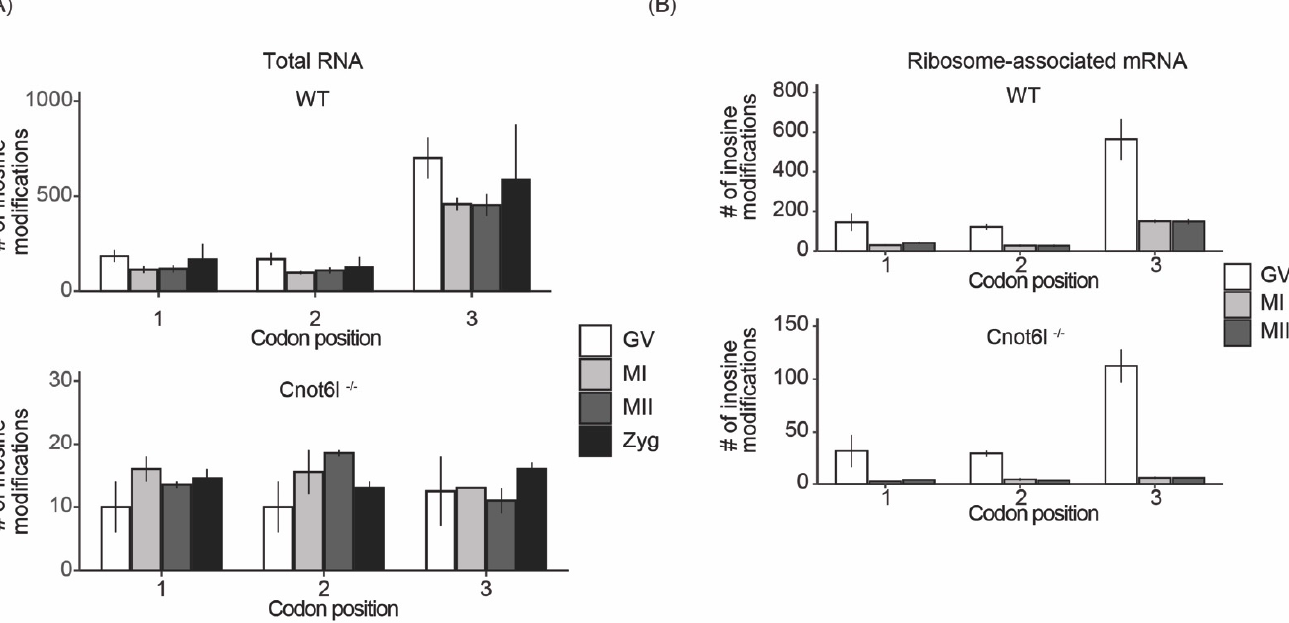
Figure 5. Inosines are enriched at the wobble position of codons in total RNA and ribosome-associated RNA. ( A , B ) Global frequency of inosine RNA modifications at the first, second, or third codon positions in WT, Cnot6l -/- , and Btg4 -/- samples in total RNA ( A ) and ribosome-associated RNA ( B ). Only codons from transcripts with TPM ≥ 1 were analyzed. 2.6. Efficiency of Inosine RNA Modifications is Highest in Ribosome-Associated mRNA Transcriptome-wide inosine RNA modification efficiency at various codons re- mained around 50% throughout oocyte maturation in WT samples (Figure 6A, Supple- mental Figure S2 shows raw counts). Conversely, Cnot6l -/- samples displayed defects in inosine RNA modification efficiency in total RNA at all stages of oocyte maturation (Fig- ure 6A, Supplemental Figure S3). An examination of inosine RNA modification efficiency in Btg4 -/- samples revealed a reduction of modification efficiency of select codons (Supple- mental Figure S4). The inosine RNA modification efficiency of zygotes decreased only in the Cnot6l -/- background (Supplemental Figure S6). The inosine RNA modification effi- ciency reached almost 100% within transcripts of ribosome-associated mRNA of WT sam- ples, and then decreased during oocyte maturation (Figure 6B and Supplemental Figure S5). Cnot6l -/- samples also displayed almost 100% efficiency of particular codons (AAA, AAC, AAT, AGA, CAA, CAG, CCA, CGA, GTA, TTA), however, other codons were not modified at all (AAG, ACG, ACT, AGG, ATT, GAC, GAG, GAT), as seen in Figure 4. Dur- ing oocyte maturation, the inosine RNA modification efficiency was completely lost at a majority of codons in Cnot6l -/- MI and MII oocytes (Figure 6B and Supplemental Figure S5). Overall, during oocyte maturation, the inosine RNA modification efficiency is almost